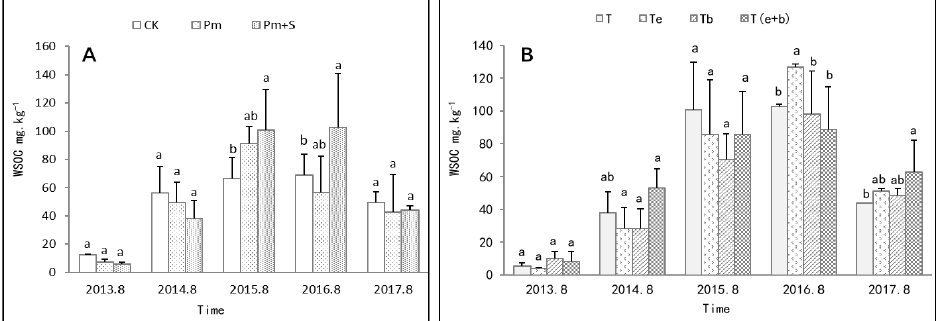
Figure 3. Dynamic change of soil water-soluble organic carbon content. Bars represent standard errors. Lower case letters above each panel show statistical significance at p < 0.05. CK pig manure, S slurry, e earthworms, b bacteria, T Pm + S, Te T + earthworms, Tb T + bacteria, T(e + b) T + earthworms + bacteria ( A ) Pig manure, biogas slurry agricultural use ( B ) Biological control.